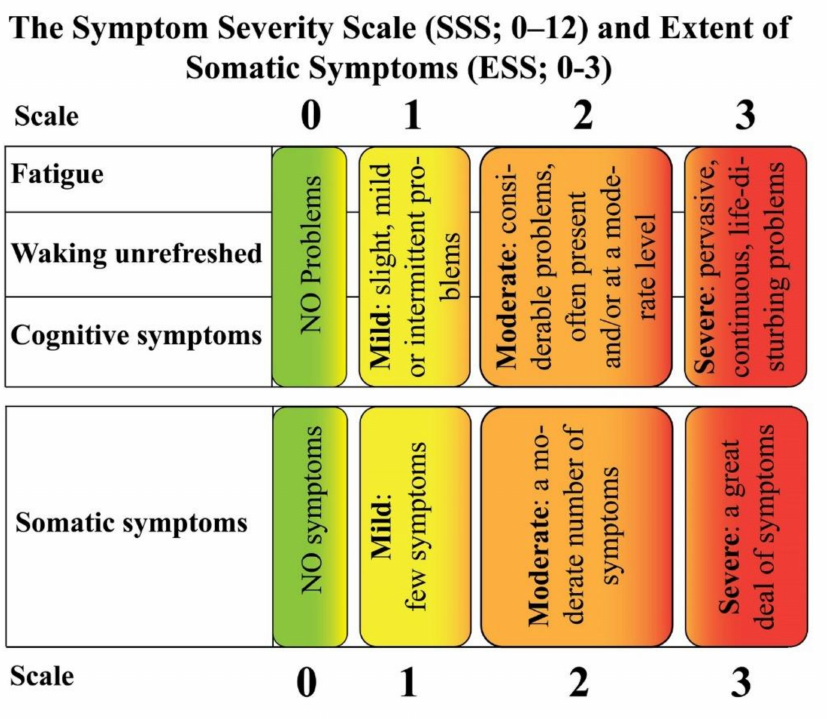
Figure 2. Symptom Severity scale (SSS) and Extent of Somatic Symptoms